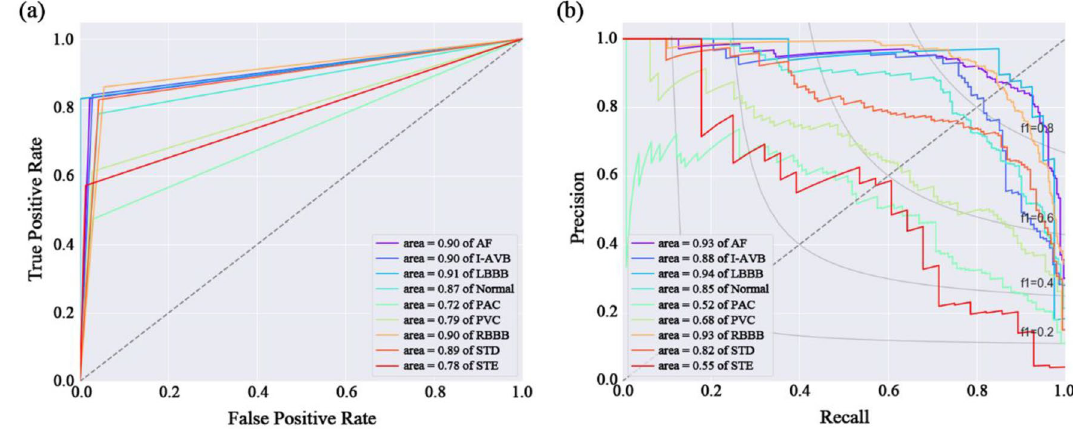
Figure 2. Performance curves for the proposed model. ( a ) Receiver operating characteristics (ROC) curves; ( b ) Precision-recall curves.